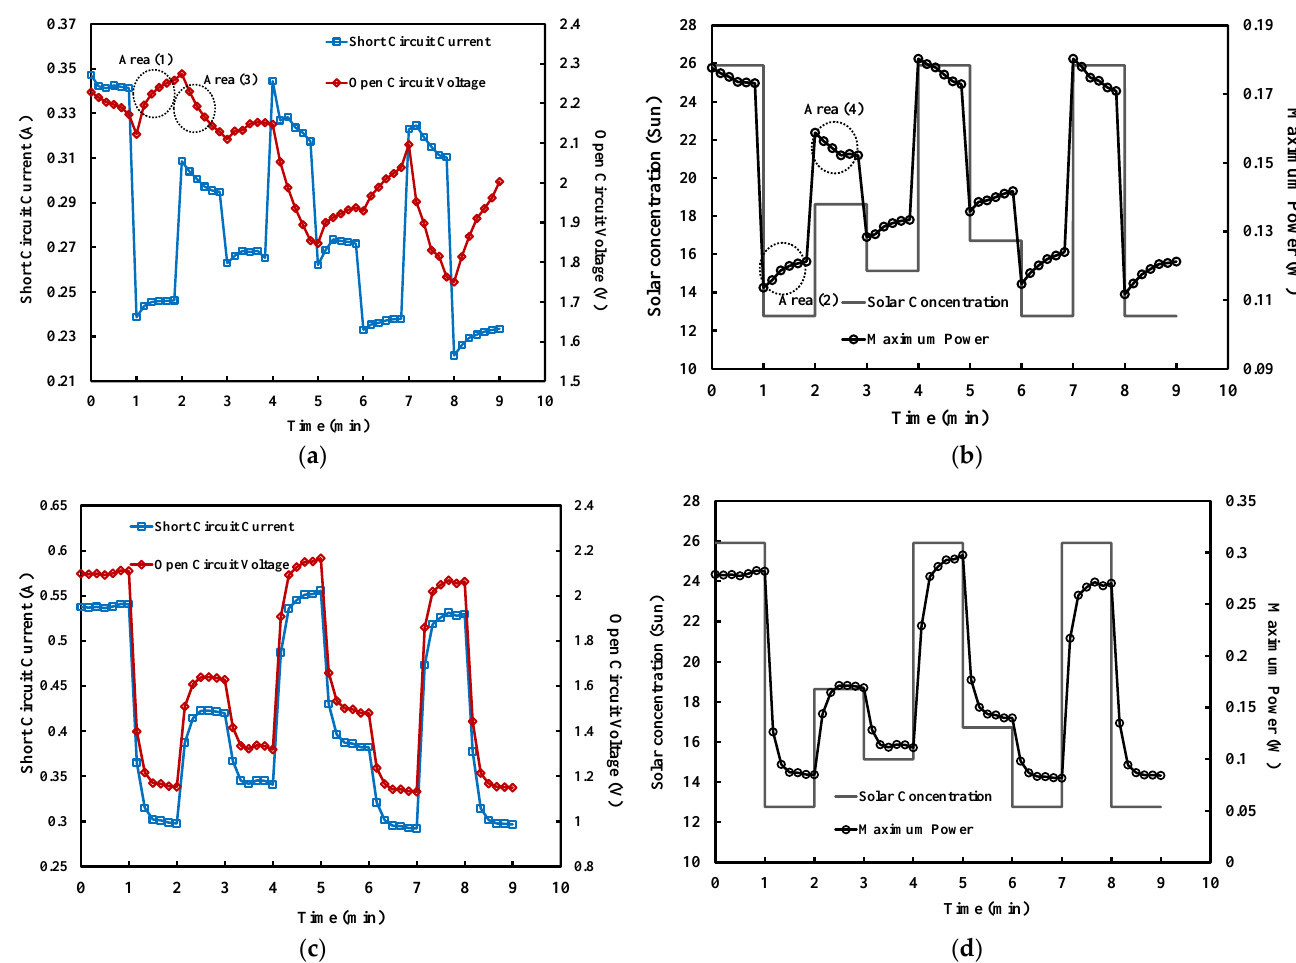
Figure 4. Maximum power, solar concentration, open-circuit voltage, and short-circuit current by ( a , b ) PV cell in PV-only system and ( c , d ) TE module in TE-only system.